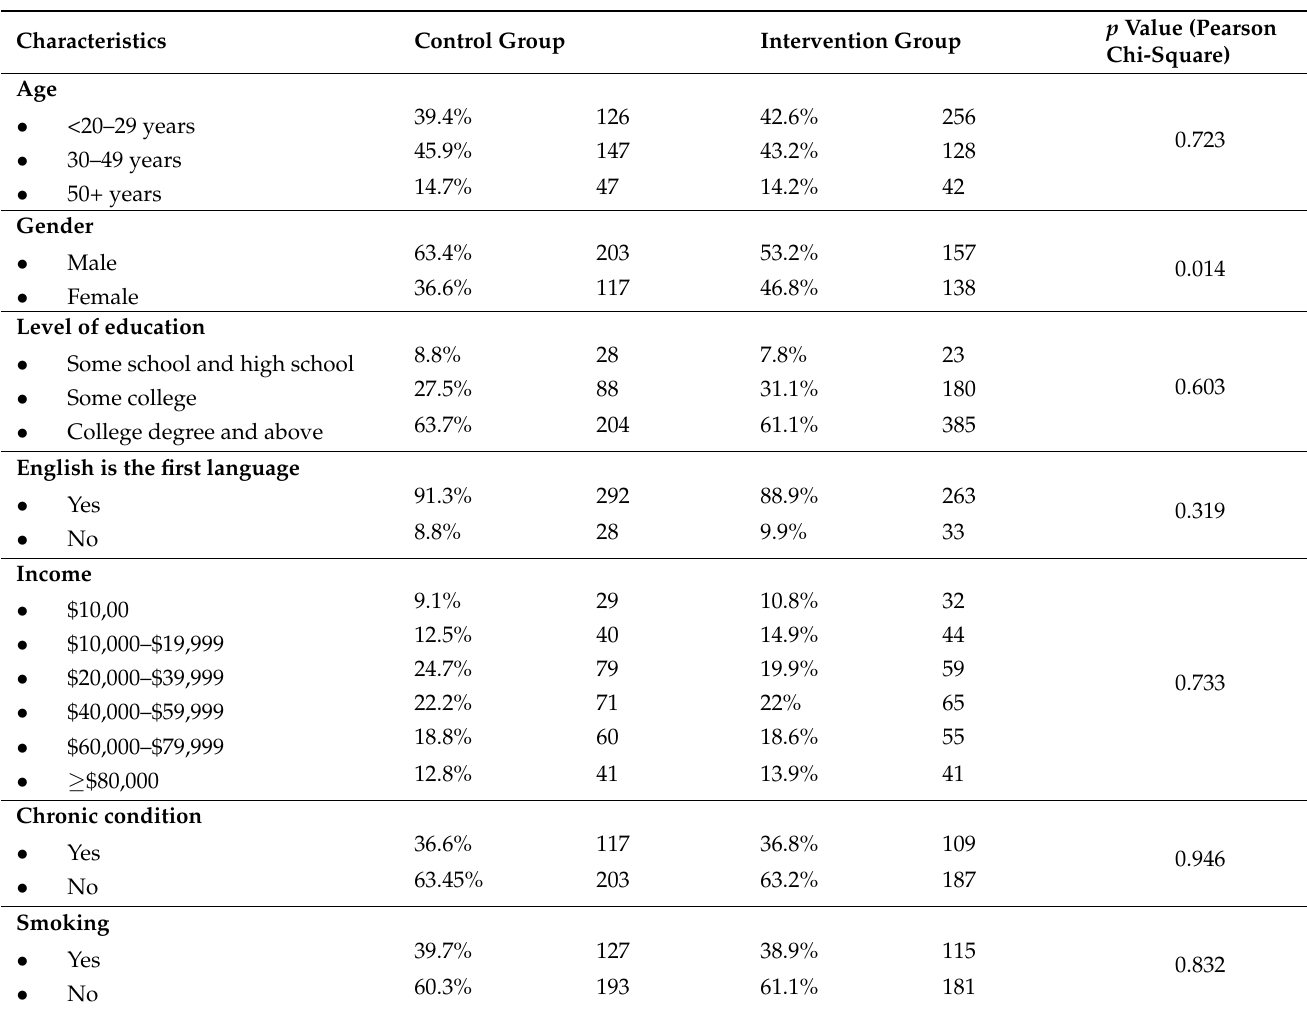
Table 2. Demographic variables (interventional